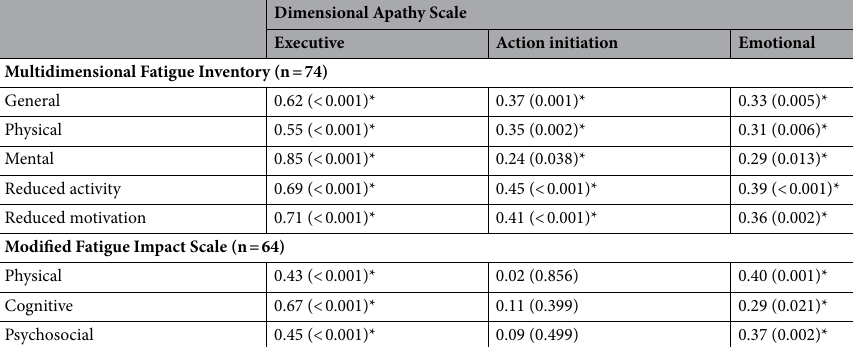
Table 2. Correlation coefficients (Spearman’s ρ) between apathy and fatigue subscales. All subscales of the DAS and MDFI were significantly correlated. The Executive and Emotional subscales of the DAS were correlated with all subscales of the MFIS, but the Action Initiation subscale of the DAS was not related to any MFIS subscale. p -values are denoted in parentheses, with asterisks indicating those that survived FDR correction at a threshold of α = 0.05.